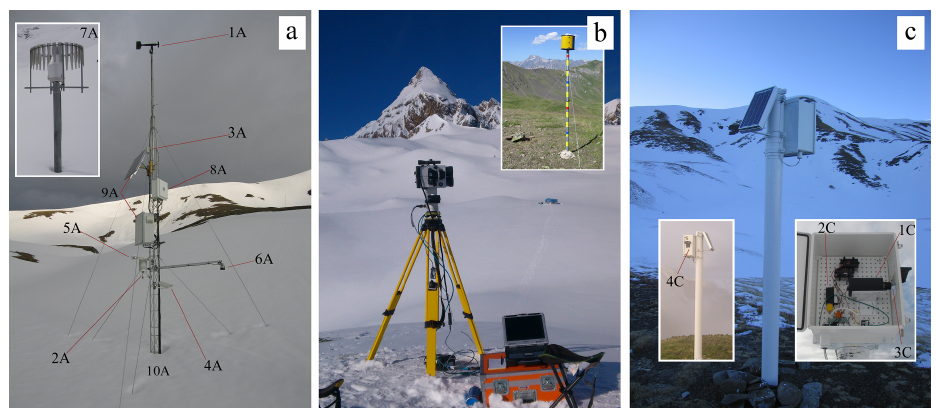
Figure 2. Pictures of the experimental site equipment. (a) AWS sensors. 1A: Young wind sensor; 2A: radiation shield with HMP 155 humidity and temperature probe; 3A: BP1 air pressure recorder; 4A: IR100 infrared remote temperature sensor; 5A: CMA6 Kipp & Zonen albedometer; 6A: SR50A range sensor; 7A: Geonor T-200B with wind shield; 8A: CR3000 data logger and modem; 9A: solar panel and battery; 10A: Campbell Scientific 107 ground temperature probes. (b) RIEGL LPM-321 TLS mounted on the tripod during an acquisition campaign. The upper-right part shows one of the 12 fixed reflective targets fixed on the terrain. (c) Campbell CC640 camera mounted in the metal structure with 1C: digital camera inside the enclosure house; 2C: modem; 3C: protection glass of the digital camera; and 4C: frontal view of the camera and its